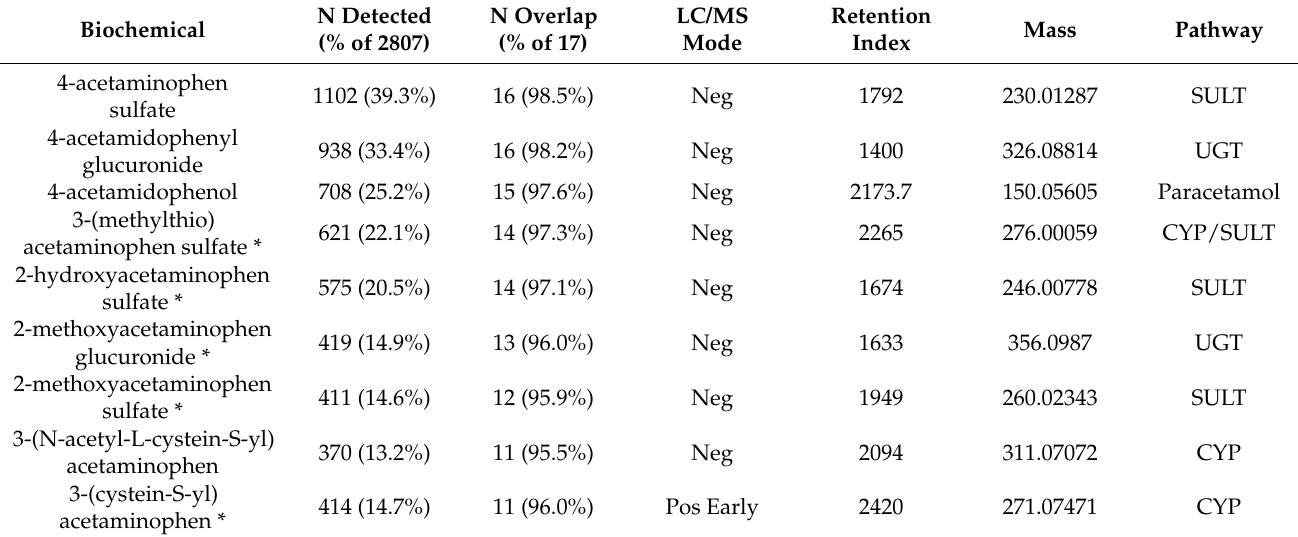
Table 4. Nine metabolites of the drug paracetamol (acetaminophen) were individually detected in between 370 and 1102 of the 2807 blood samples, with a joint detection of all nine metabolites in 310 samples. LC/MS characteristics of the detected molecules are provided together with the biochemical detoxification pathway in which the respective molecules are involved (see